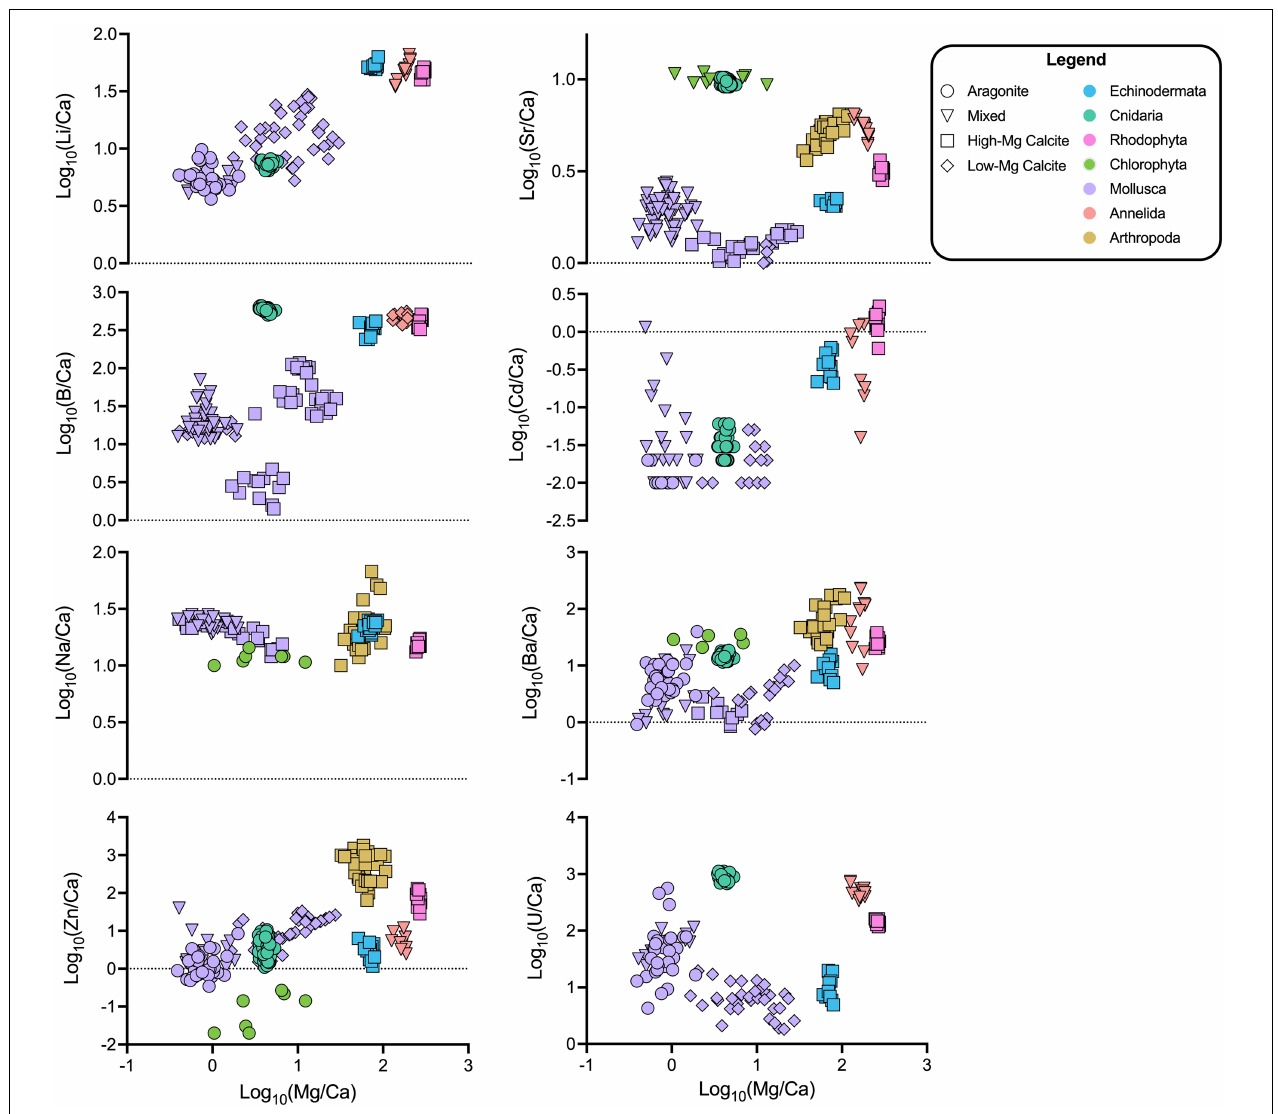
FIGURE 2 | Elemental ratio data plotted against Mg/Ca (log10-transformed values are shown. Color and shape indicate phylum and mineralogy, respectively. Generalized additive models (GAMs) of this data show a number of significant relationships between elemental ratios and Mg/Ca, explaining 0–71% of the variance in the data ( Supplementary Table 4 ). Grouping the organisms by phylum or mineralogy substantially improves model performance, and the best-performing models consider either or both grouping variables (38.70–99.00% of variance explained; Table 6